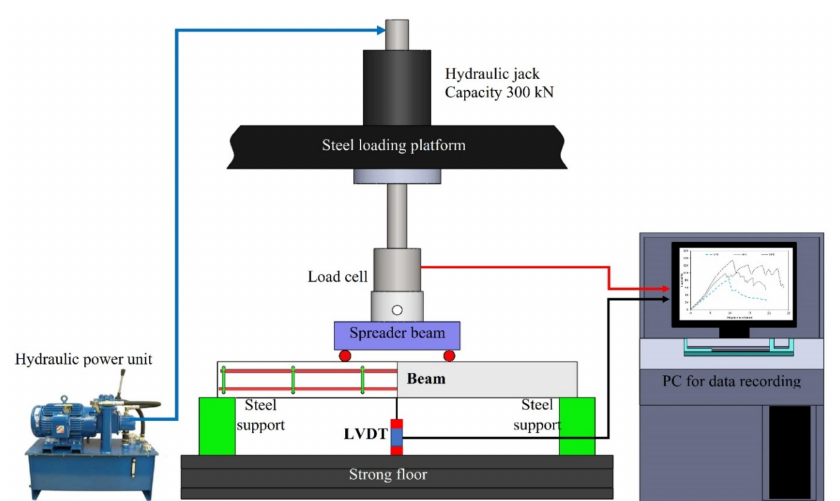
Figure 5. Test Setup and